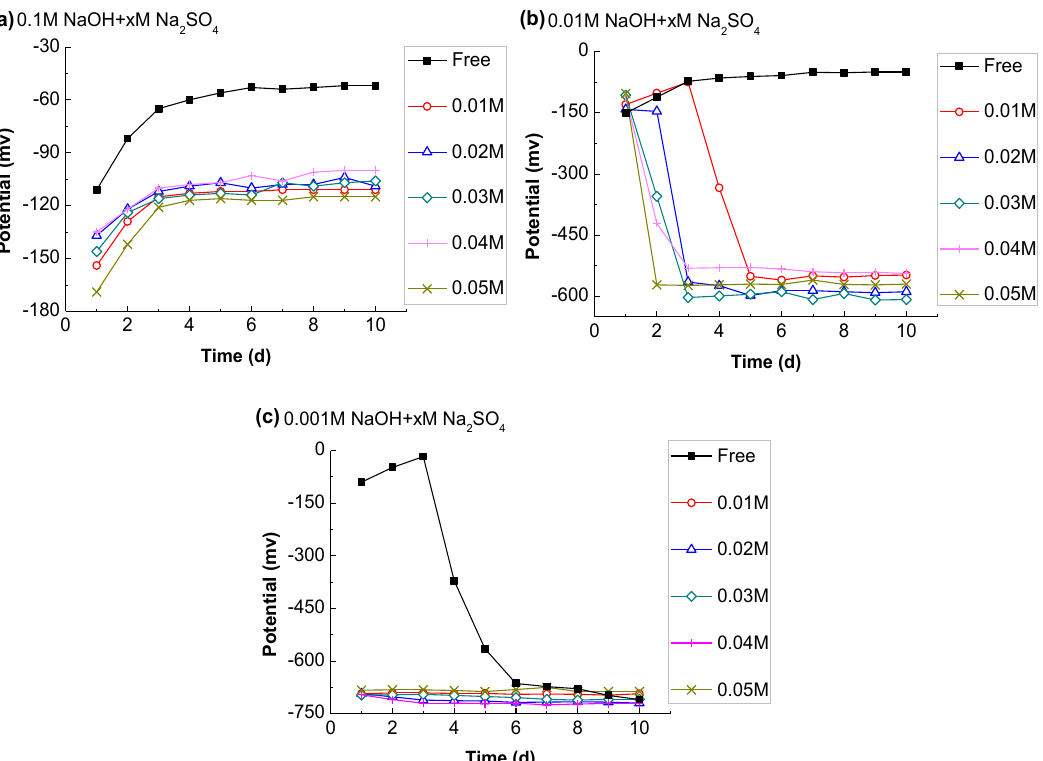
Figure 5. Effect of SO 42 − concentrations on the OCP. ( a ) 0.1 M NaOH + x M Na 2 SO 4 ; ( b ) 0.01 M NaOH + x M Na 2 SO 4 ; ( c ) 0.001 M NaOH + x M Na 2 SO 4.